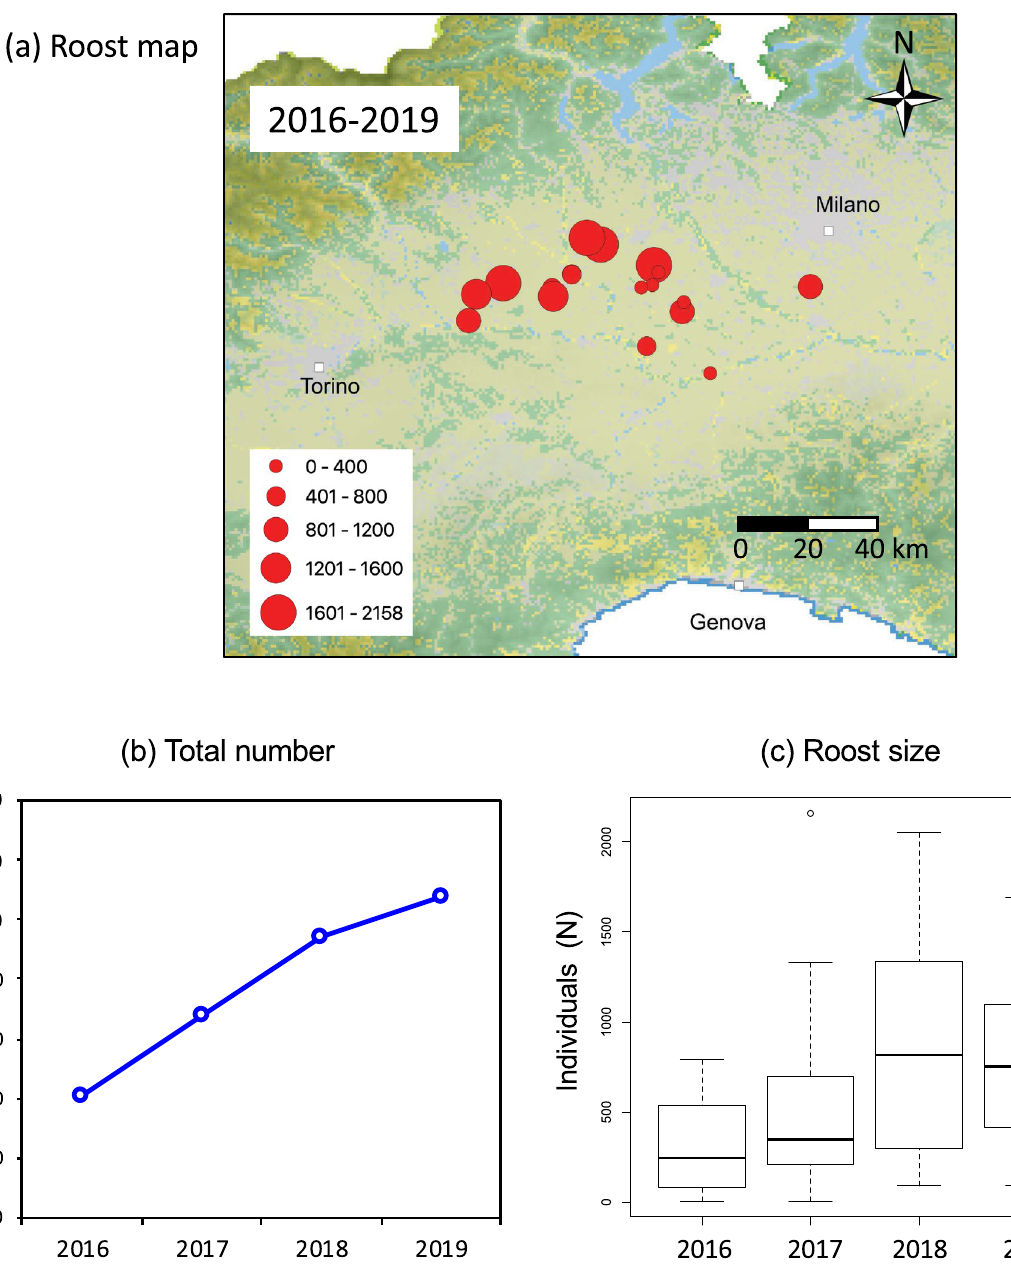
Figure 3. Sacred ibis presence at post-breeding roosts in the period from 2016–2019: ( a ) map of the roost sites in NW Italy; ( b ) total number of individuals; ( c ) median size of roosts. Maps generated using QGIS ver. 3.4